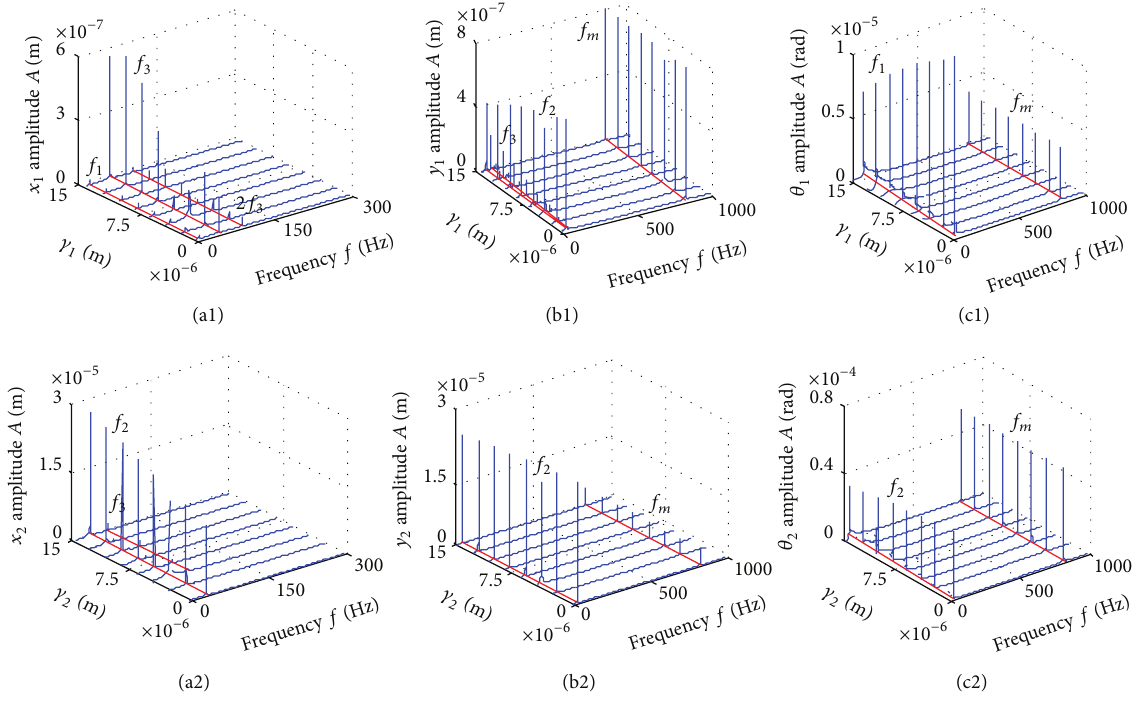
Figure 12: 3D frequency spectrum of the gears in lateral and torsional